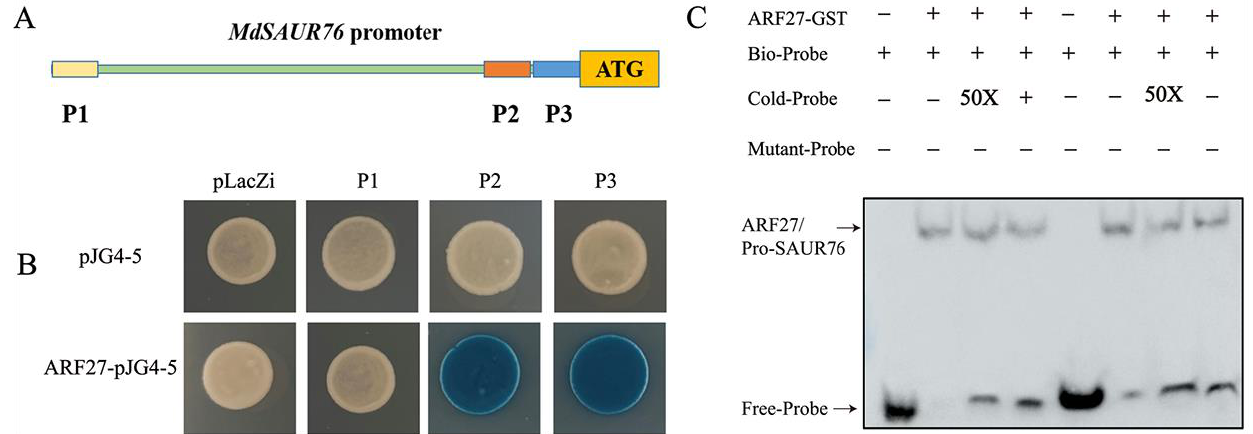
Figure 9. Interaction of MdIAA27 with the promoter of MdSAUR76 . ( A ) Schematic diagram of the MdSAUR76 promoter region; ( B ) Y1H confirmation of the binding of MdSAUR76 promoter P2 and P3 fragments by MdARF27; ( C ) EMSA assay showing that MdARF27 could directly bind to the promoters of MdSAUR76 (P2 and P3). The plus and minus signs indicate the presence or absence of that protein, respectively.